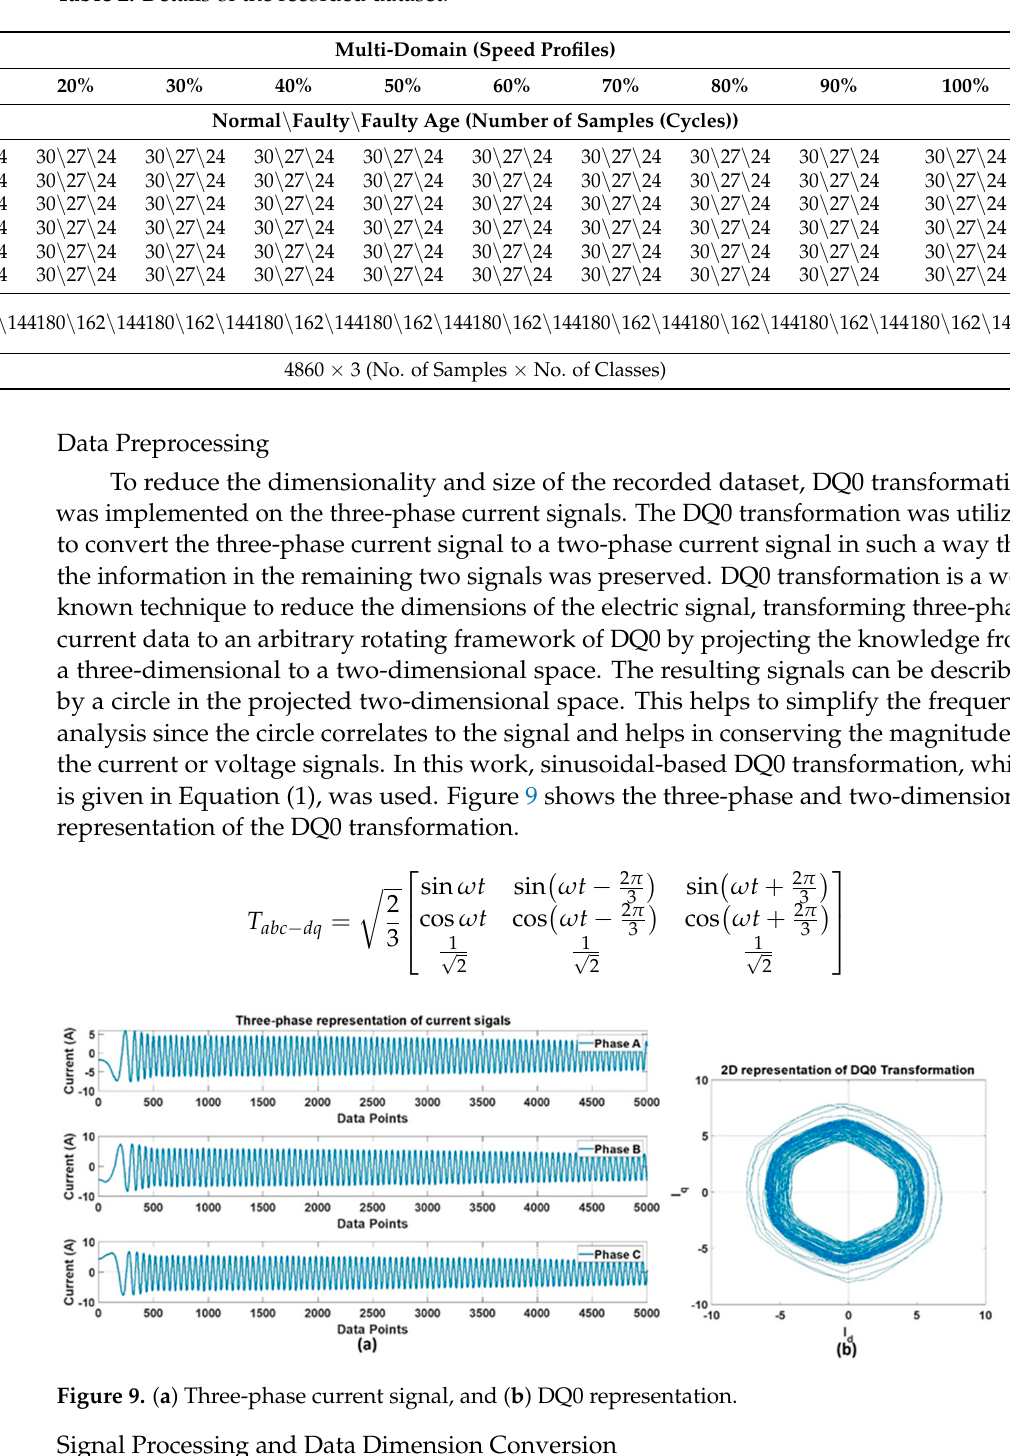
Table 2. Details of the recorded dataset.